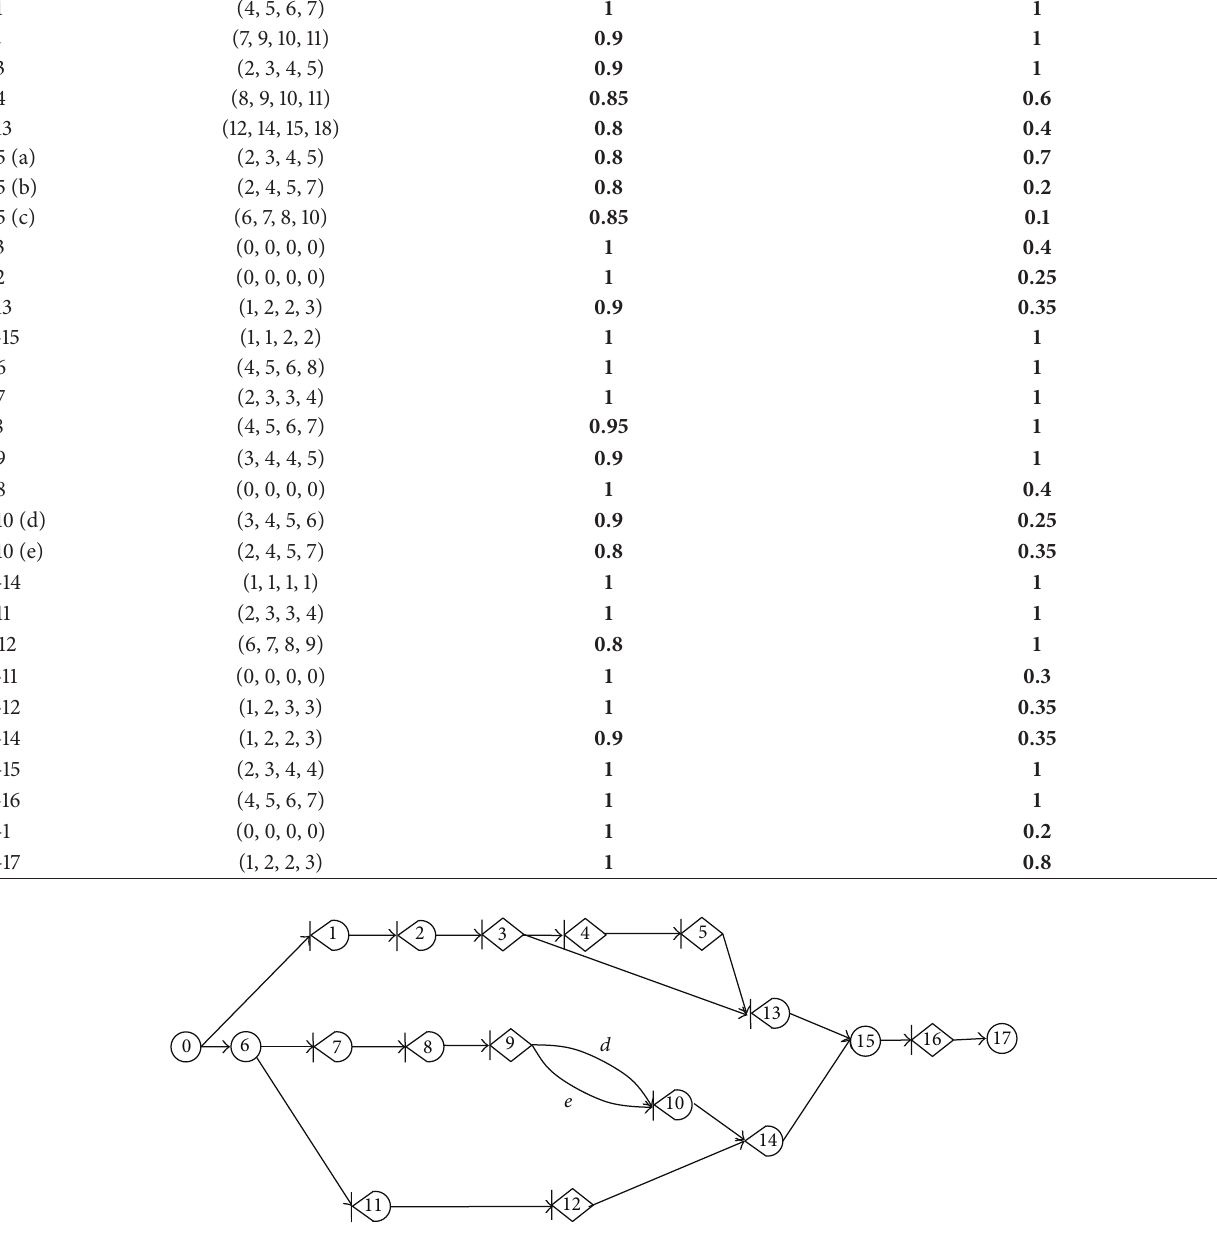
Figure 7: Activity network of the R&D project without any